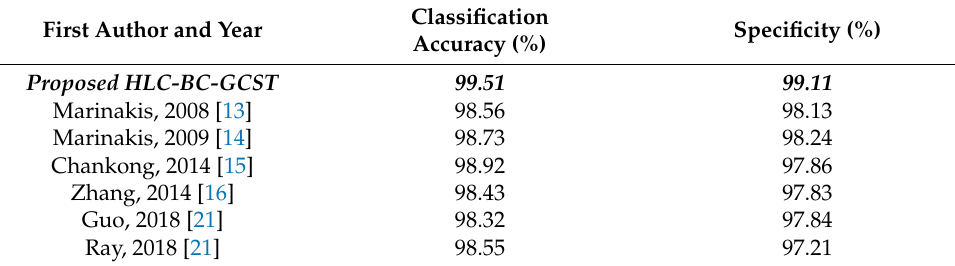
Table 1. Comparative Performance: Accuracy and Specificity.